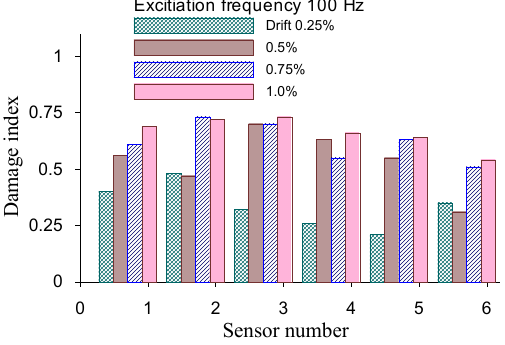
Figure 12. Damage index at each drift ratio for RCW 1 (excitation frequency 100 Hz).